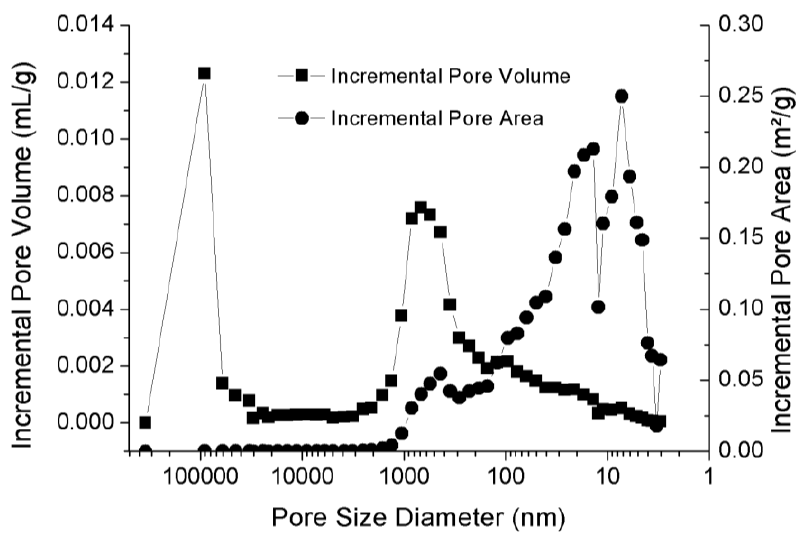
Figure 1. Pore size distribution defined by incremental pore volume and pore area [24].